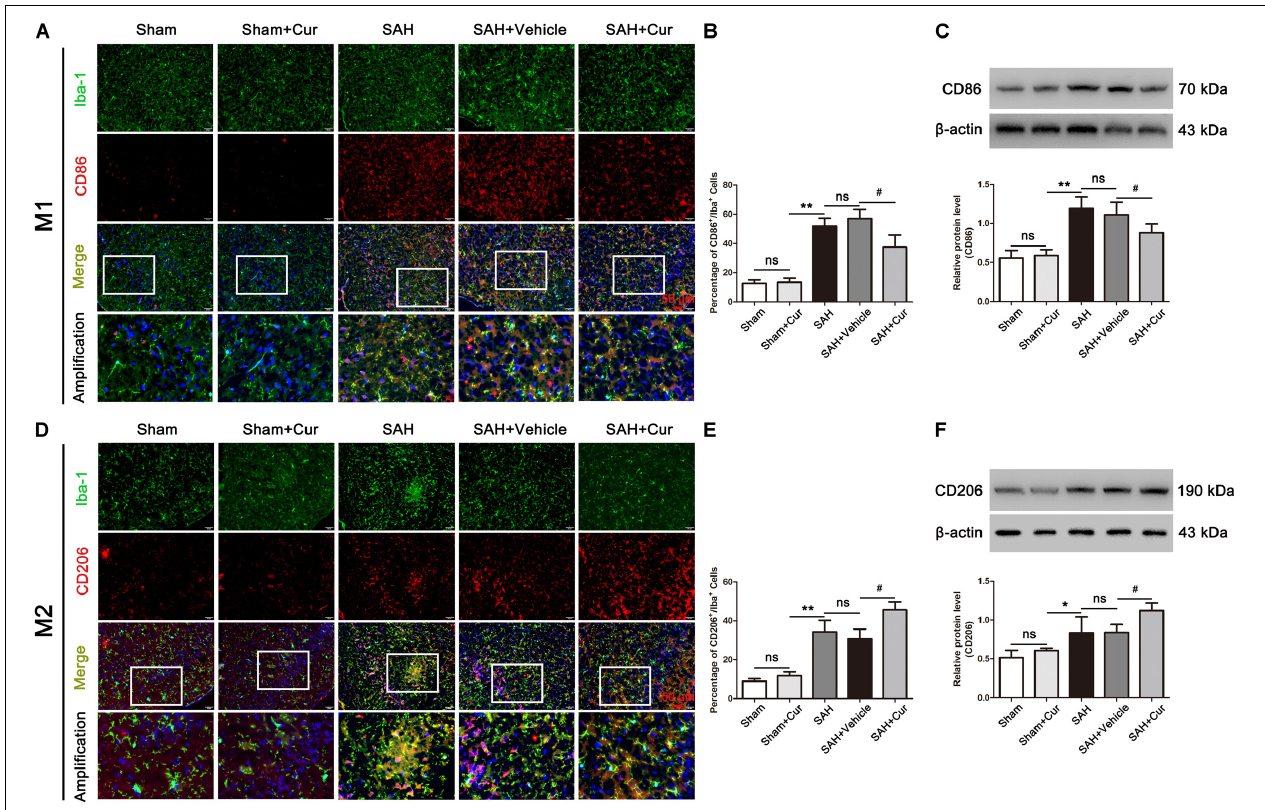
FIGURE 5 | Effects of curcumin treatment on microglia polarization at 24 h after SAH. (A,D) Representative immunofluorescence staining images of M1 (Iba-1 + /CD86 + , Iba-1 = green, CD86 = red) and M2 (Iba-1 + /CD206 + , Iba-1 = green, CD86 = red). Amplification images of phenotype M1 and M2 shown in white box of all groups. (B,E) Quantification showed that curcumin treatment reduced the elevated proportion of M1 (Iba-1 + /CD86 + ), and further elevated the amount of M2 (Iba-1 + /CD206 + ) at 24 h after SAH compared with the SAH + vehicle group. (C,F) Curcumin administration decreased the protein level of CD86 and increased the expression of CD206 as compared with the SAH + vehicle group at 24 h after SAH. The quantitative data are the mean ± SD ( n = 8, each; ∗ p < 0.05, ∗∗ p < 0.01 vs. Sham + Cur group; # p < 0.05 vs. SAH + Vehicle group; ns p > 0.05). Scale bars = 50 µ